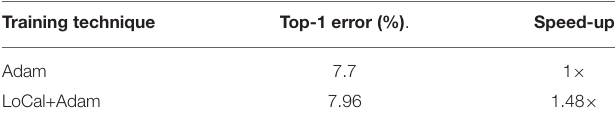
TABLE 6 | Accuracy and runtime benefits of LoCal+Adam. Training technique